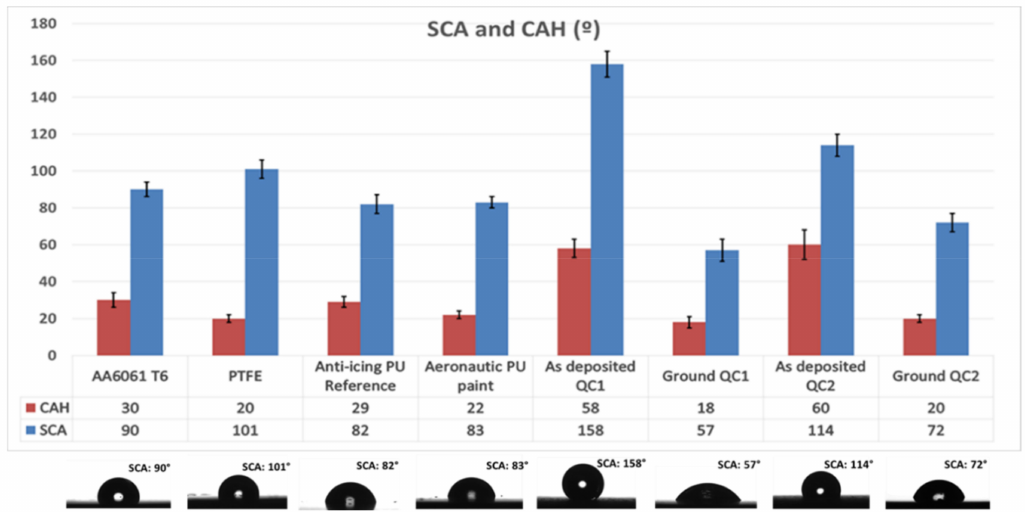
Figure 12. Static contact angle (SCA) and contact angle hysteresis (CAH), of the studied samples. The roll-o ff angle (RoA) of all samples was higher than 55 ◦